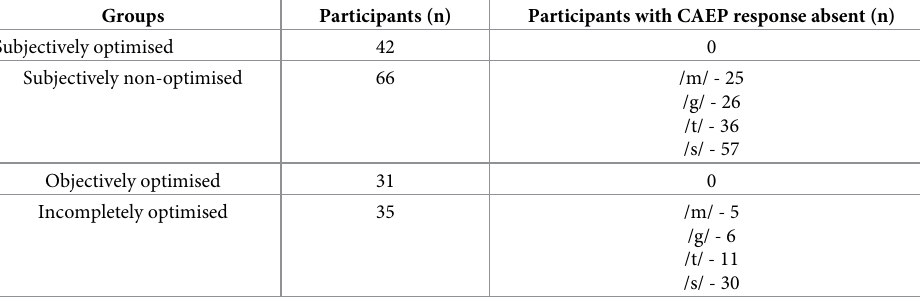
Table 2. Distribution of participants who had absent CAEP for each speech token.